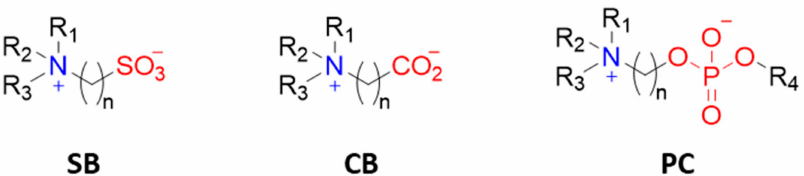
Figure 11. Most commonly used zwitterionic moieties: sulfobetaine ( SB ), carboxybetaine ( CB ), and phophorylcholine ( PC ).